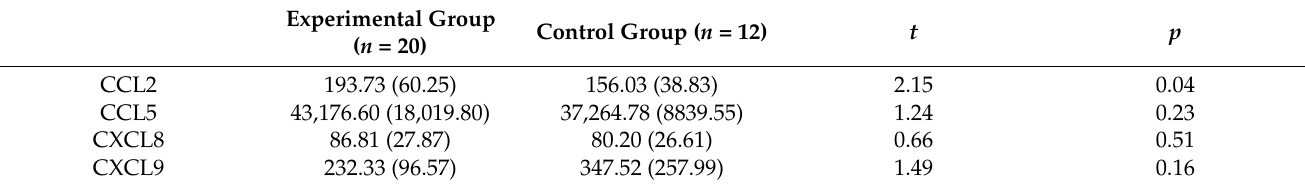
Table 2. Comparison of chemokine concentrations between experimental and control group at the baseline. Experimental